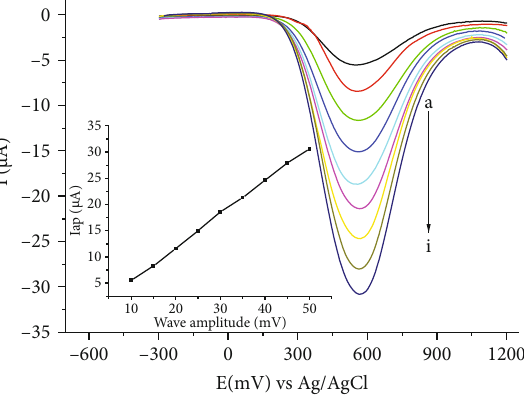
Figure 5: SWVs of AQMCPE in pH 4 PBS containing 2.0mM AA at di ff erent amplitudes (a – i: 10, 15, 20, 25, 30, 35, 40, 45, and 50mV, respectively). Inset: plot of anodic peak current vs. square wave amplitude.